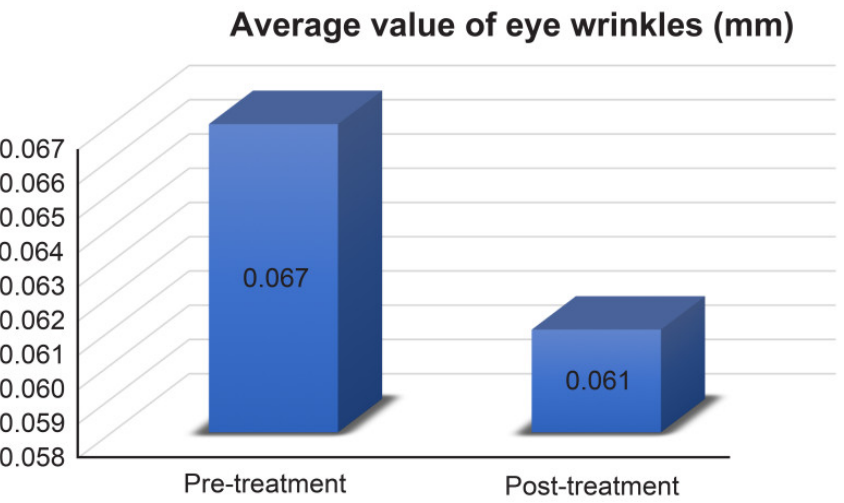
Figure 1. Average values of eye wrinkles measurement results. Pre-treatment 0.067 ± 0.038 mm,